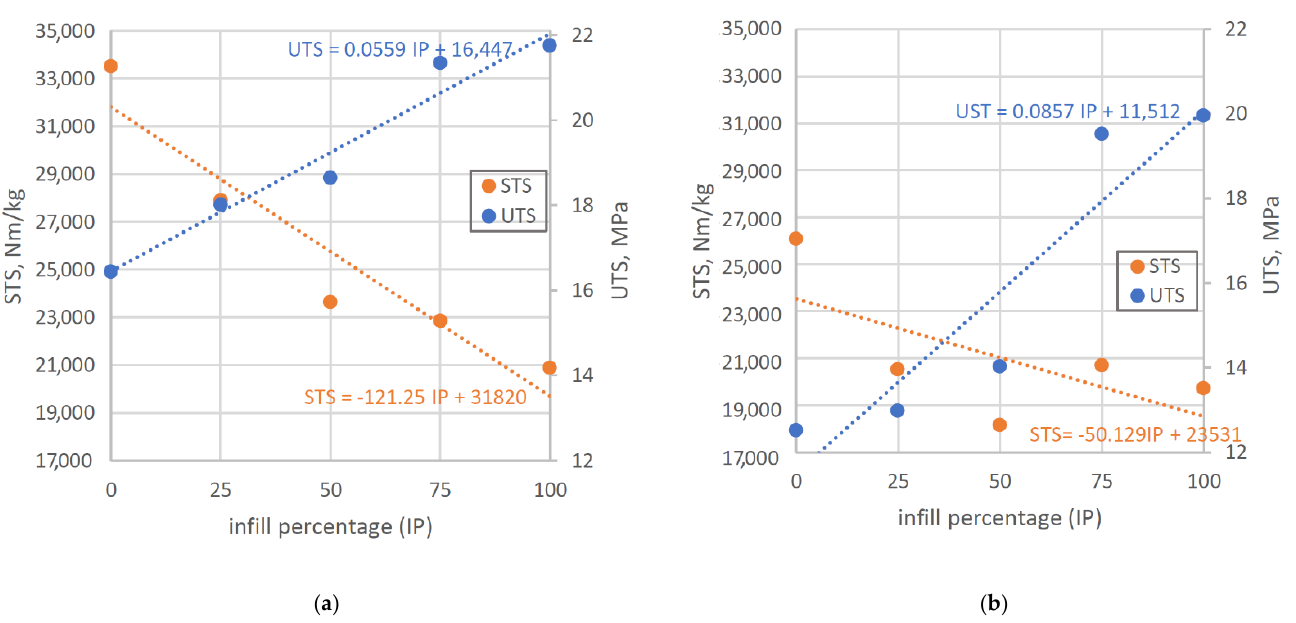
Figure 6. UTS/STS vs. infill percentage graphs for PET-G ( a ) and PLA ( b ).